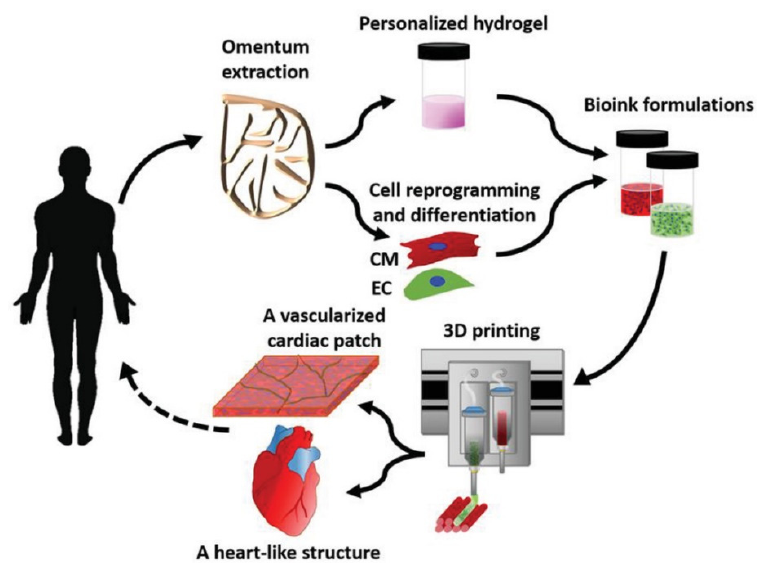
Figure 6. Concept schematic of bioprinting a patient-specific personalized cardiac tissue